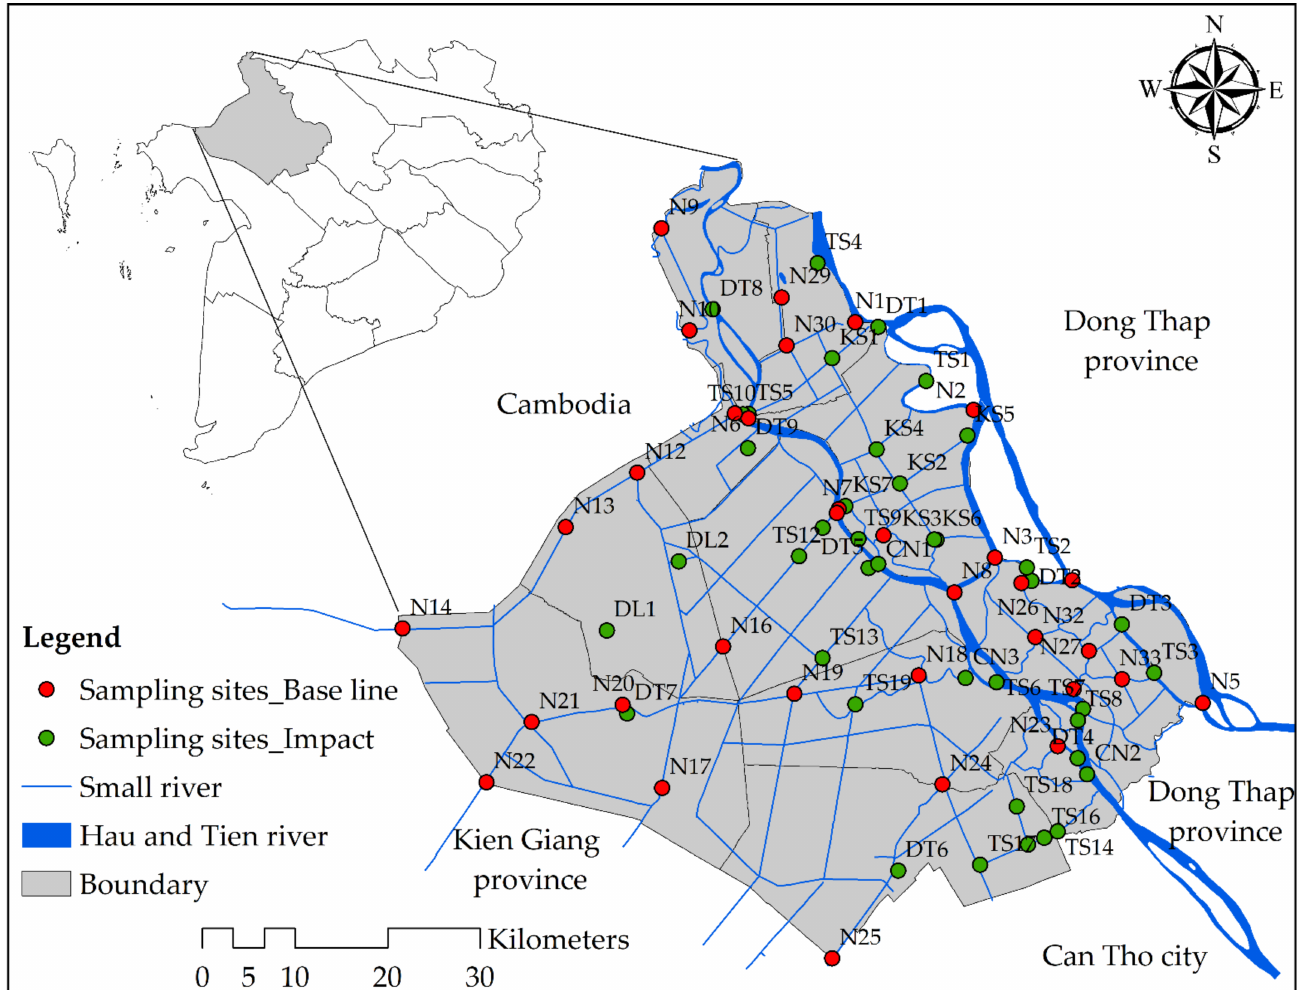
Figure 1. Map of the sampling sites in the study